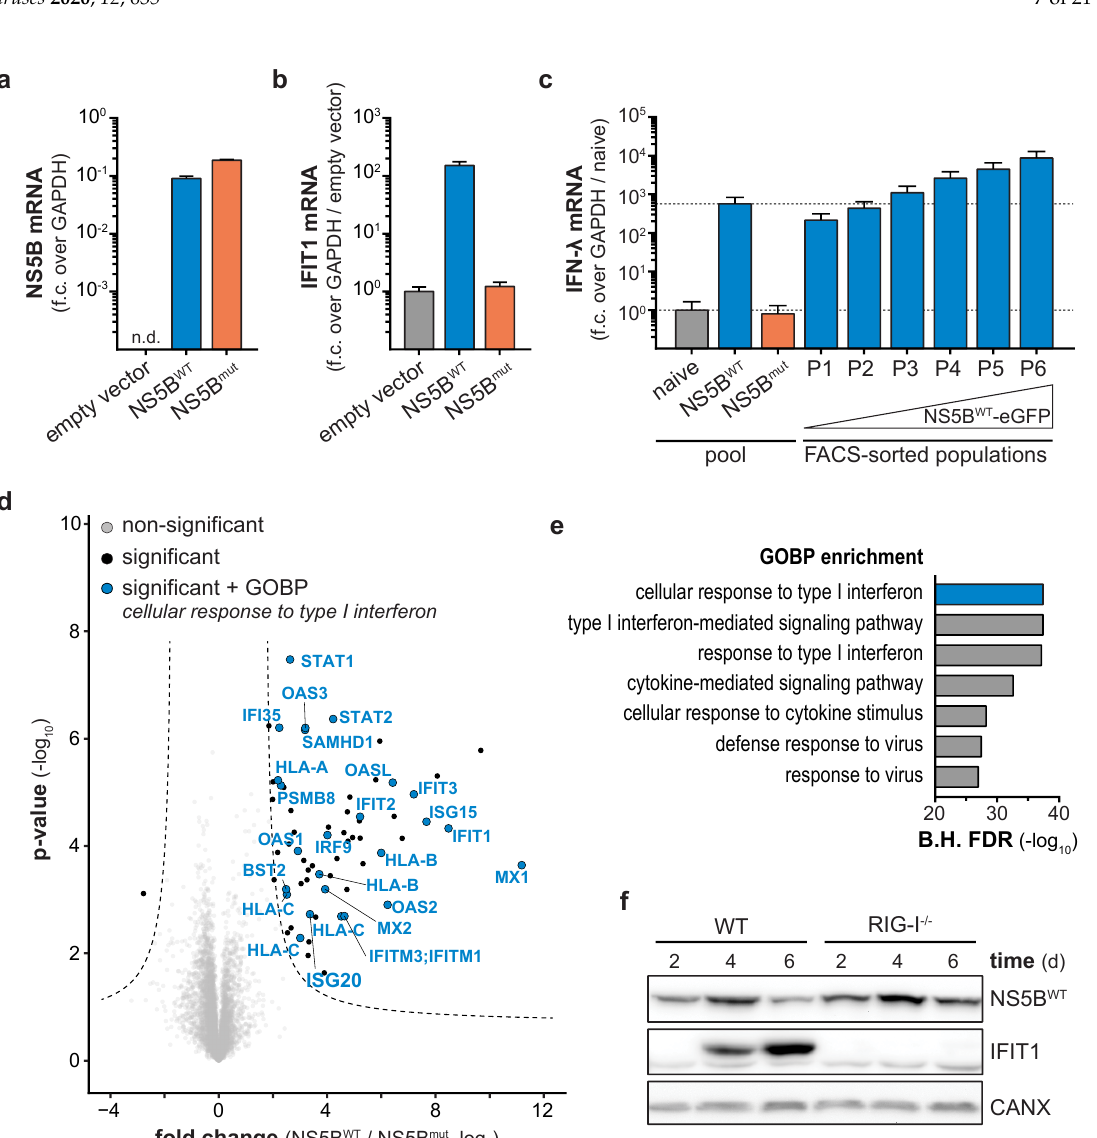
Figure 1. Ligand-based stimulation of retinoic acid inducible gene I (RIG-I) by expression of